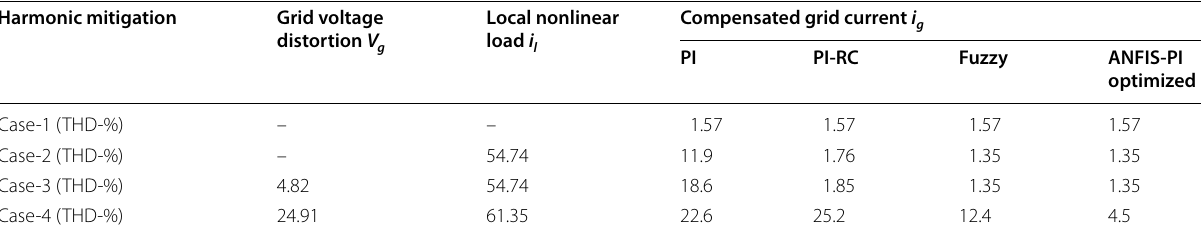
Table 3 Comparative study of DG current controllers for harmonic mitigation Harmonic mitigation